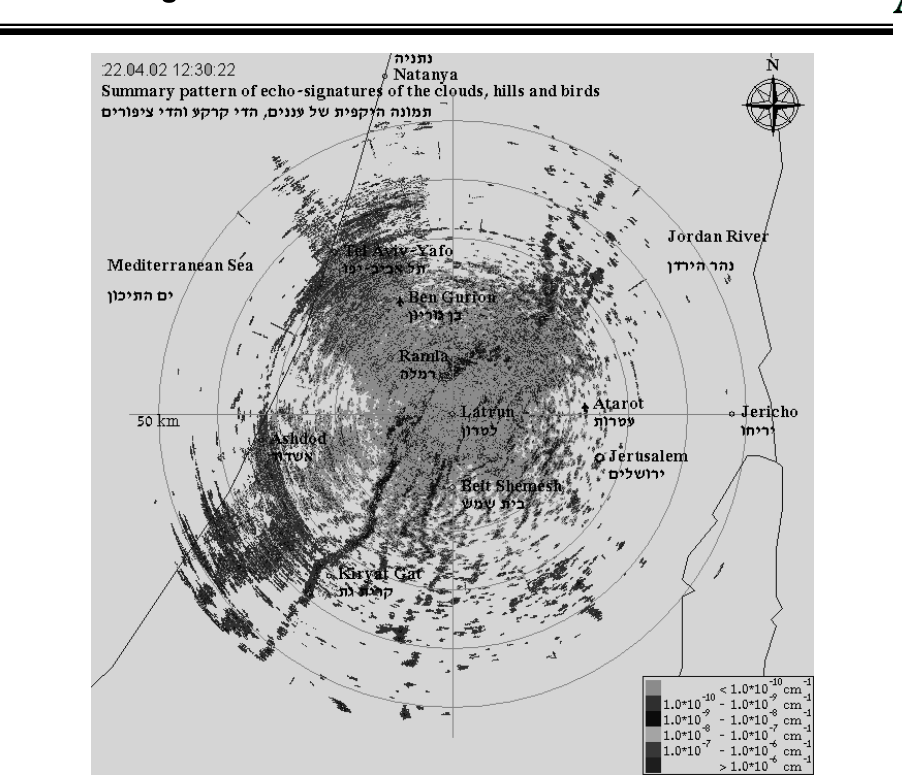
Рис. 1. Миграция осоеда, 22 апреля 2002 г., 12:30 PM (по результатам обработки радарных данных).